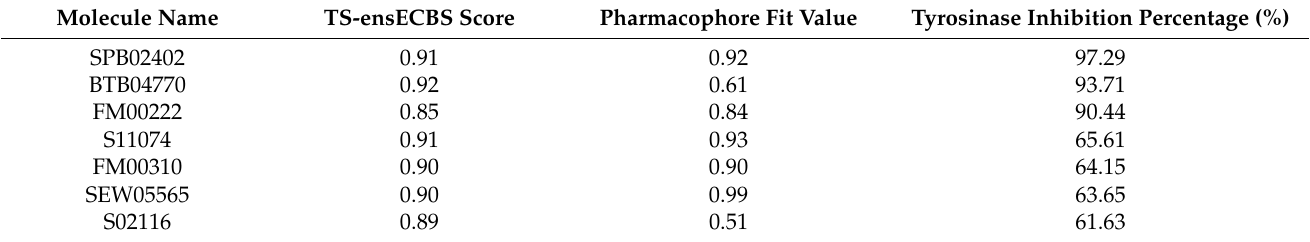
Table 1. The output values from TS-ensECBS, pharmacophore model, and tyrosinase inhibition assay for the seven newly identified inhibitors are